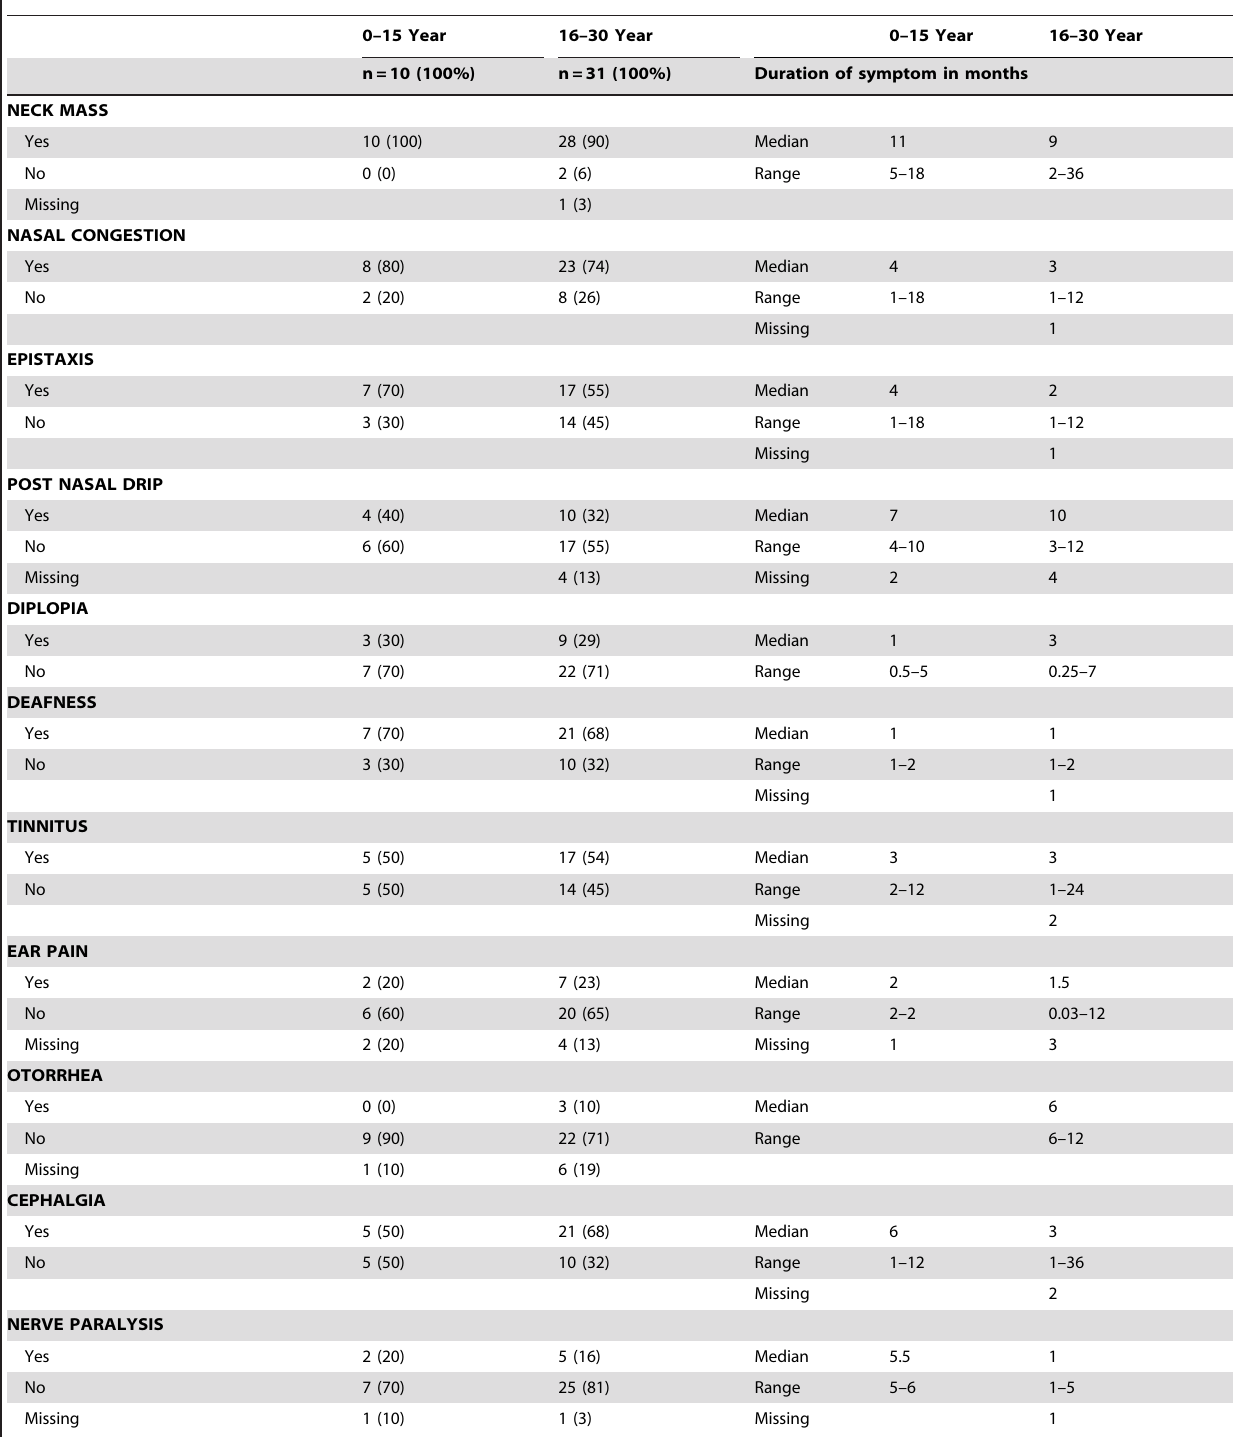
Table 2. Complaints at diagnosis and interval between first appearance and